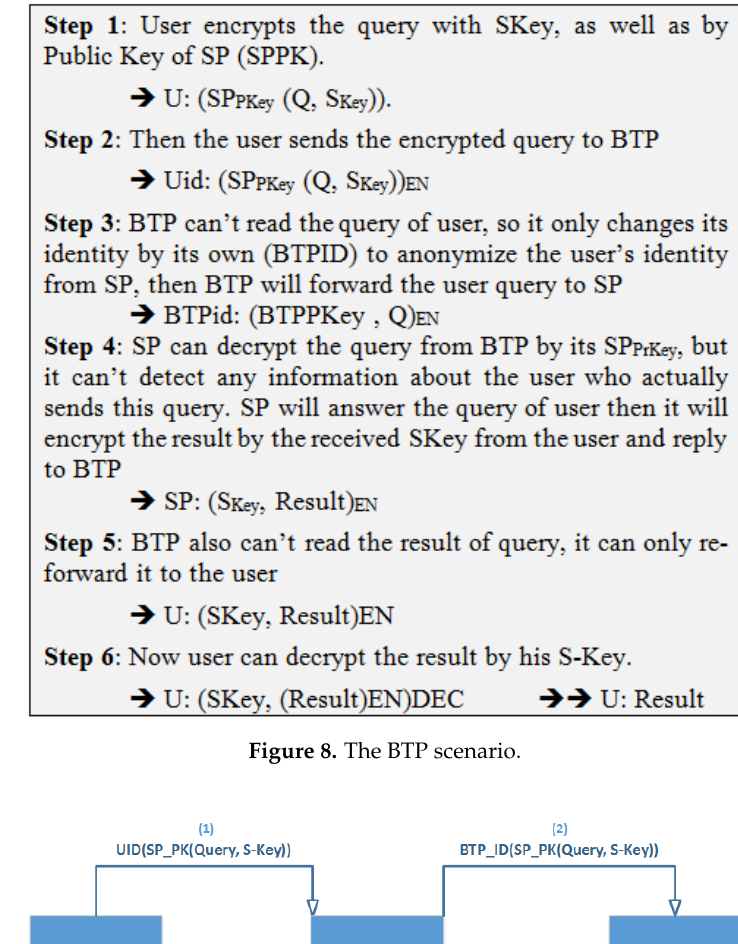
Figure 8. The BTP scenario.